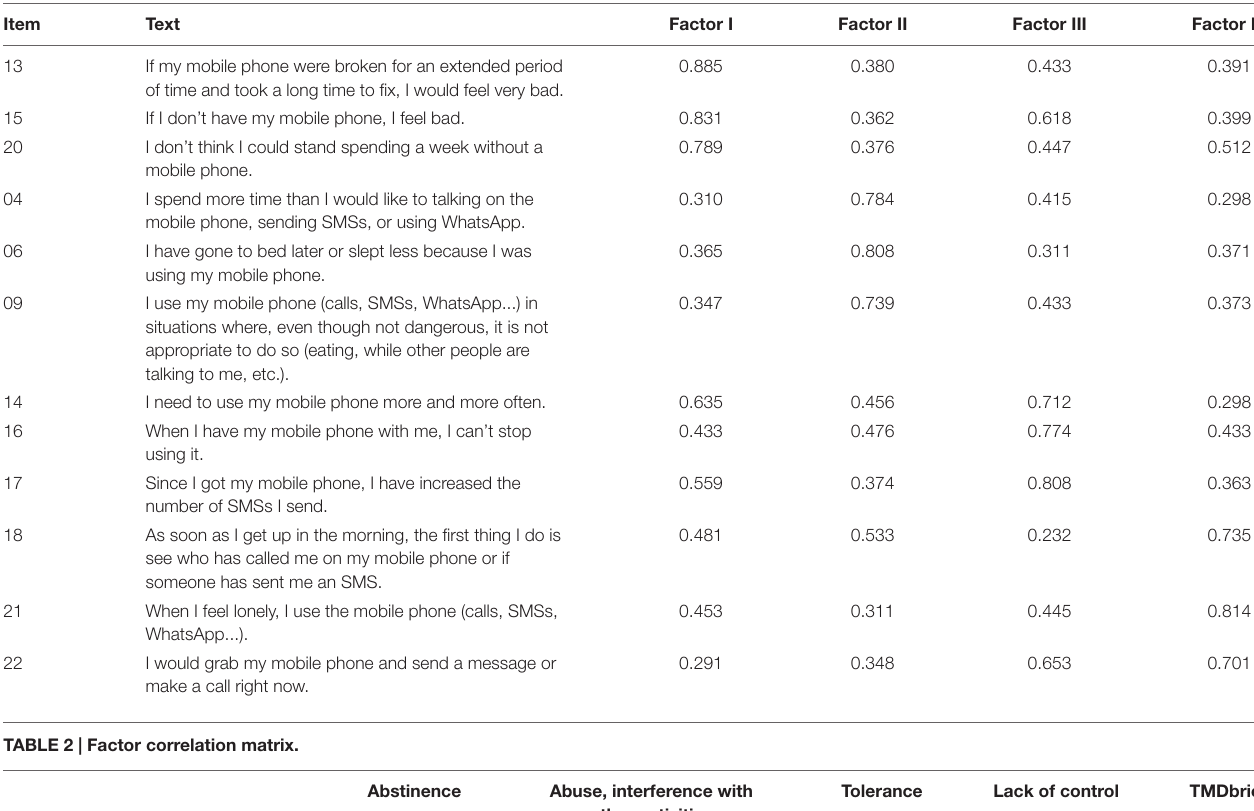
Abstinence Abuse, interference with other activities